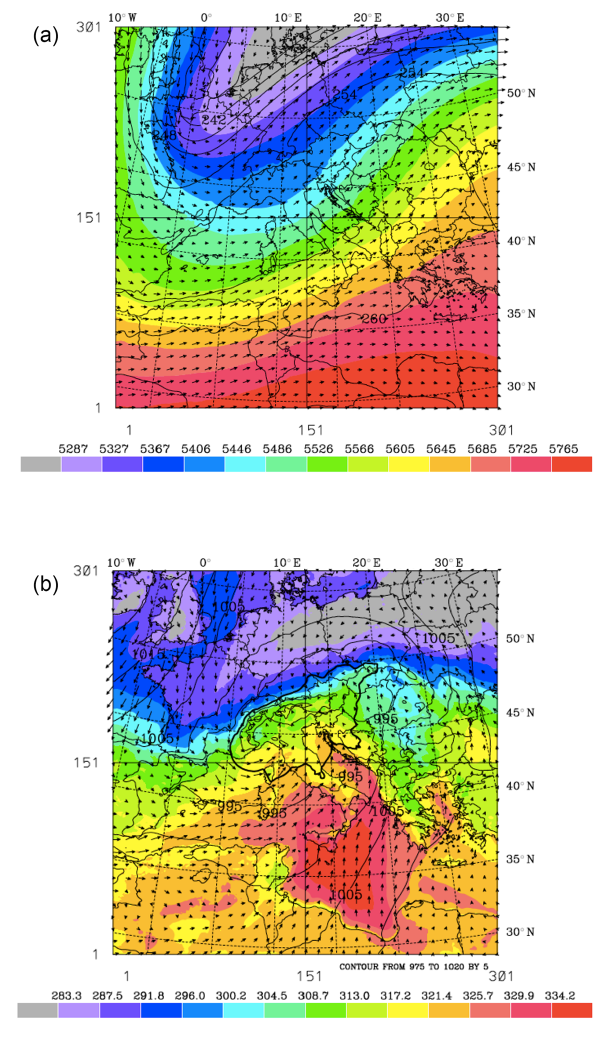
Figure 3. Synoptic situation at 12:00UTC on 27 October 2012. (a) 500hPa: temperature (black contours from 236 to 263K ev- ery 3K), geopotential height (filled contours, values shown by the colour bar at the bottom), and wind vectors (maximum wind value 41ms − 1 ). (b) Surface: sea level pressure (contour from 975 to 1020hPa every 5hPa, the thick line is the 990hPa contour), equiv- alent potential temperature (filled contours, values shown by the colour bar at the bottom), and winds (maximum wind vector is 17ms − 1 ) simulated at 25m above the underlying surface in the terrain-following coordinates of RAMS. This figure is derived from the RAMS run at 10km horizontal resolution. The bottom and left axes show the grid point number, while the top and right axes show the geographical